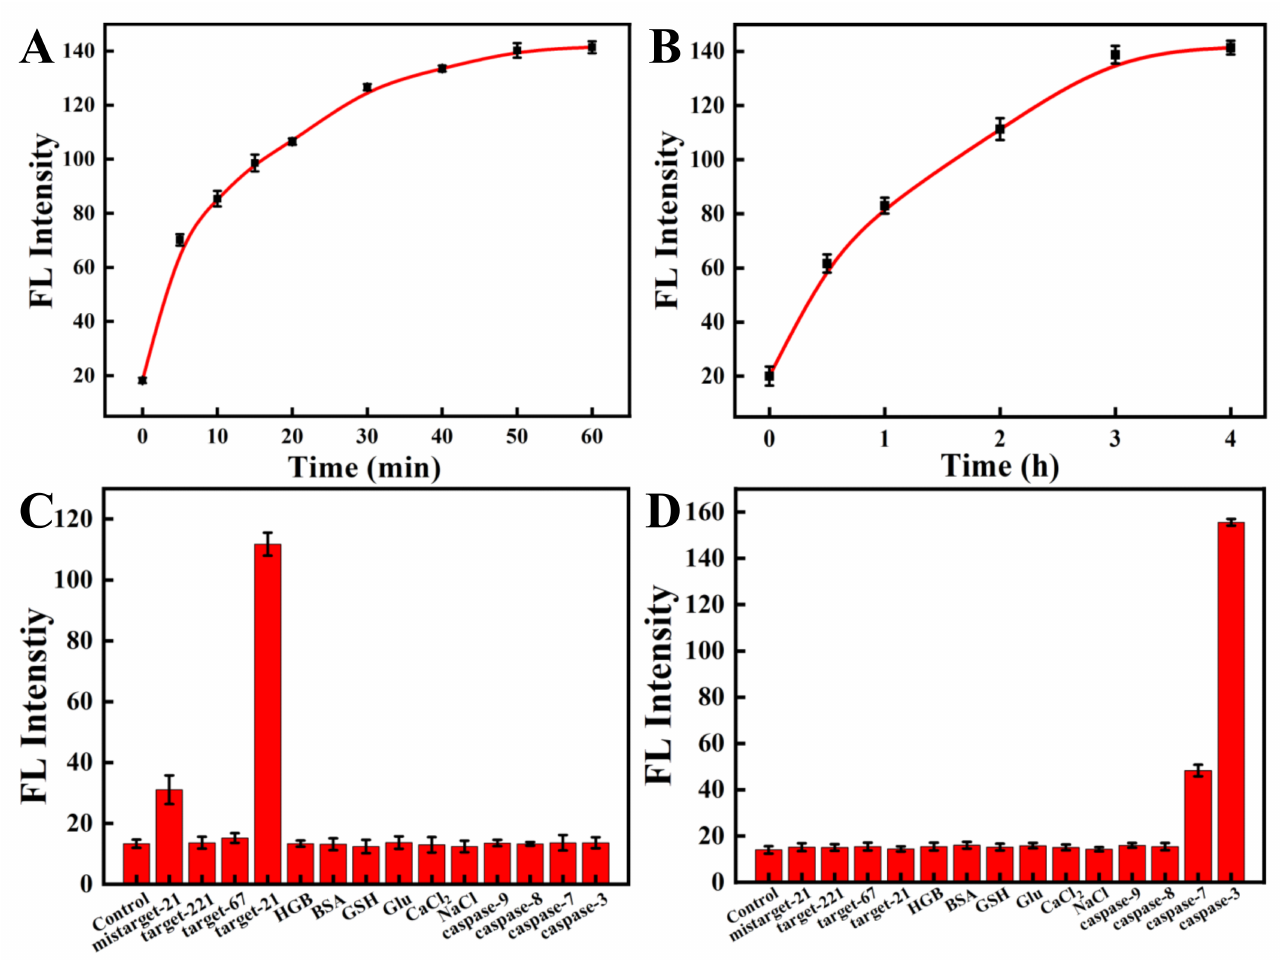
Figure 3. Kinetics of the nanoprobe in the presence of miRNA-21 ( A ) and caspase-3 ( B ). (Cy5-labeled ssDNA, targeting miRNA-21, λ ex/ λ em = 648 nm/667 nm; FITC-labeled oligopeptide, targeting caspase-3, λ ex/ λ em = 480 nm/520 nm). The specificity experiments of ssDNA ( C ) and peptide ( D ) modified on the